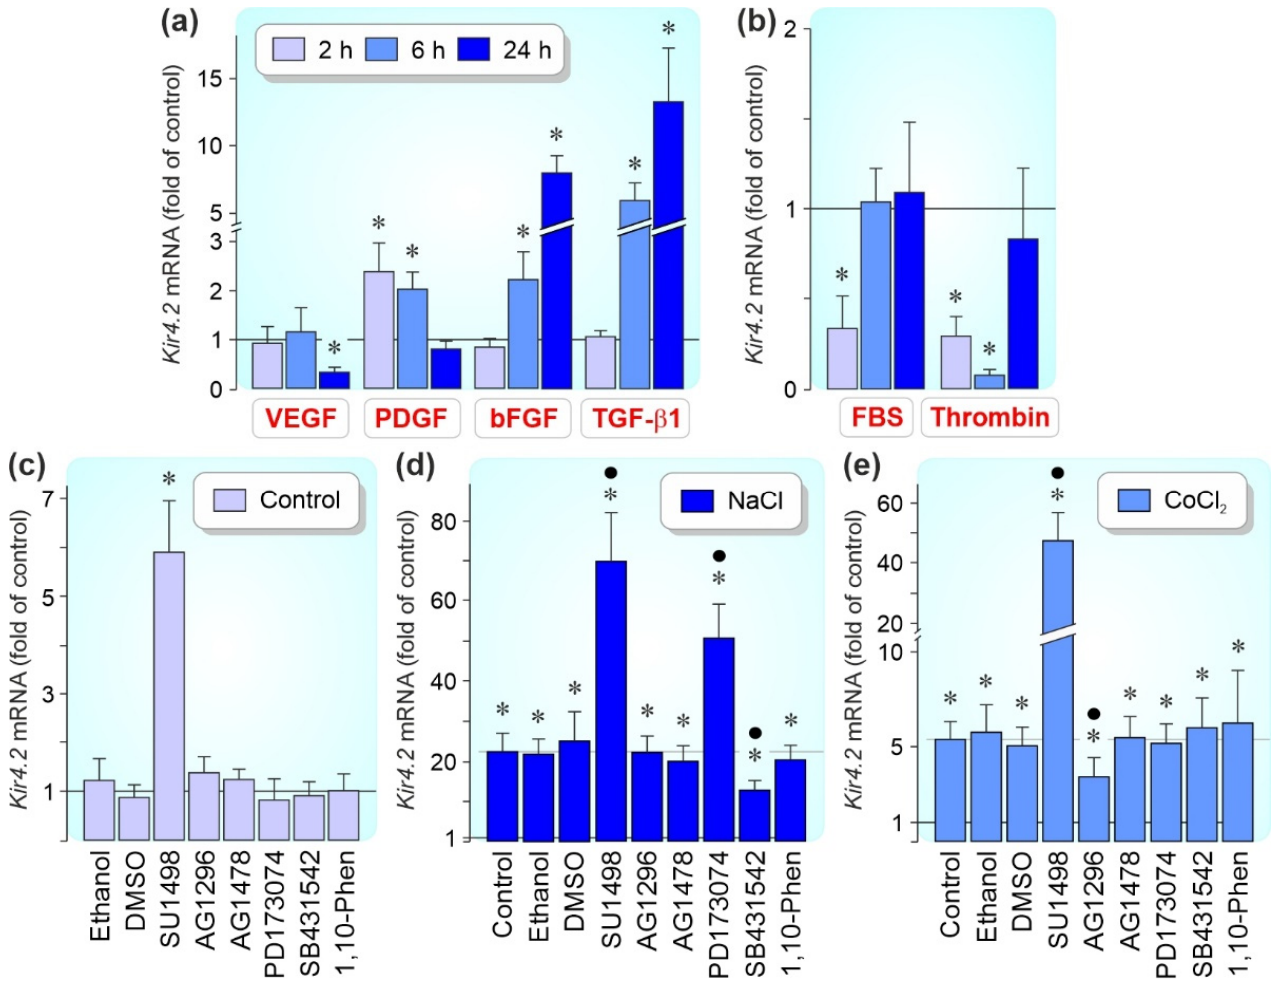
Figure 6. Effects of growth and blood factors on the Kir4.2 gene expression in cultured RPE cells. ( a , b ). Real-time RT-PCR was performed with total RNA extracted from cells which were stimulated 2, 6, and 24 h. The relative mRNA level is shown as fold of unstimulated control (1). ( a ) Effects of exogenous VEGF, PDGF, bFGF, and TGF- β 1 (each at 10 ng/mL) on the Kir4.2 transcript level in cells cultured under control conditions. ( b ) Effects of fetal bovine serum (FBS; 10%) and thrombin (10 U/mL) under control conditions. ( c – e ) Effects of receptor blockers on the Kir4.2 gene expression in cells cultured 24 h in the absence ( c ) and presence of high (+100 mM) NaCl ( d ) and CoCl 2 (150 µM; ( e )), respectively. The following compounds were applied: the inhibitor of the VEGF receptor-2, SU1498 (10 µM), the blocker of the PDGF receptor tyrosine kinase, AG1296 (10 µM), the EGF receptor tyrosine kinase inhibitor AG1478 (600 nM), the inhibitor of the FGF receptor kinase, PD173074 (500 nM), the blocker of TGF- β 1 superfamily activin receptor-like kinase receptors, SB431542 (10 µM), and the broad-spectrum metalloproteinase inhibitor 1,10-phenanthroline (1,10-Phen; 10 µM). The effects of ethanol (1:100) and dimethylsulfoxide (DMSO; 1:500) are shown as vehicle controls. Each bar represents data obtained in 3–8 independent experiments using cells of different donors. Significant difference vs. unstimulated control: * p < 0.05. Significant difference vs. NaCl and CoCl 2 control, respectively: • p <